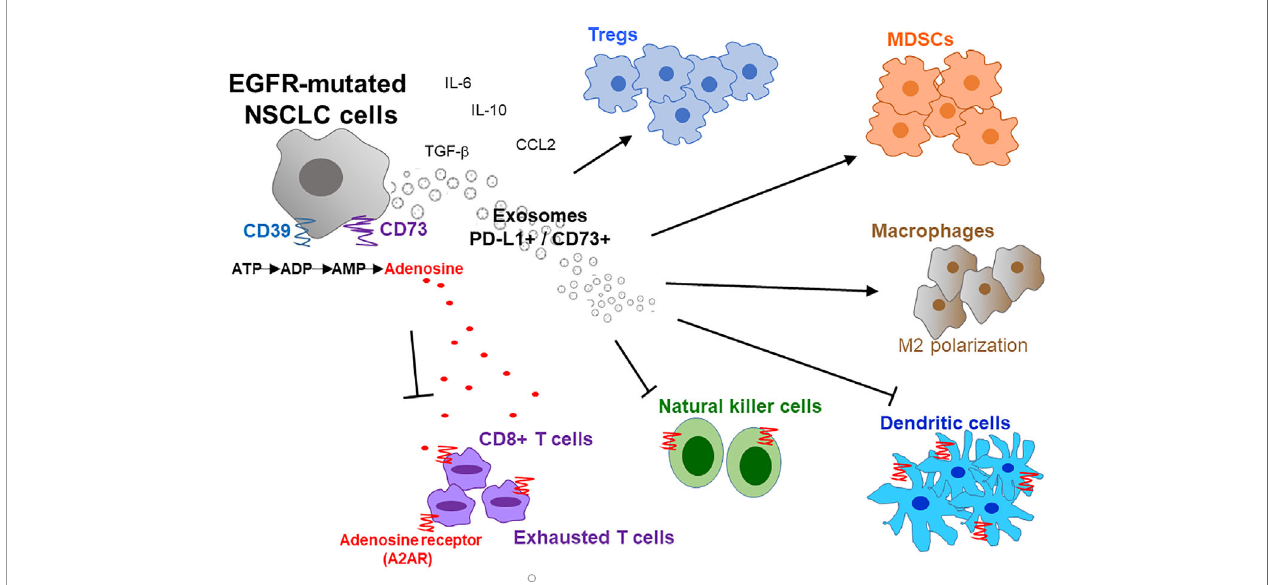
FIGURE 1 | Immunosuppressive tumor microenvironment (TME) in EGFR-mutated NSCLC. EGFR mutations promote an immunosuppressive TME by interfering with several intracellular pathways and modulating immune accessory cells including tumor-in fi ltrating lymphocytes (TILs), natural killer cells (NK), T-regulatory cells (Tregs), myeloid-derived suppressor cells (MDSCs) and tumor-associated macrophages (TAMs). Overexpression of CD39/CD73 in EGFR-mutated NSCLC induces high extracellular production and release of adenosine that inhibit the activity of innate and adaptive immune system cells and endothelial cells in TME. Activation of CD39 triggers the de-phosphorylation of ATP to ADP, and subsequently to AMP. On the other hand, CD73 catalyzes the hydrolysis of AMP to adenosine and phosphate. The increased level of extracellular adenosine bind to A2A adenosine receptor (A2AR) expressed by both adaptive and innate immunity, thereby inhibiting the activity of various immune cells. Moreover, exosomes secreted from EGFR-mutated NSCLC cells also increase PD-L1+/CD73+ expression and extracellular adenosine release to promote immunosuppression. IL, interleukin; M2, macrophages 2; ATP, adenosine triphosphate; ADP, adenosine diphosphate; AMP, adenosine monophosphate; CCL2, C-C motif chemokine ligand